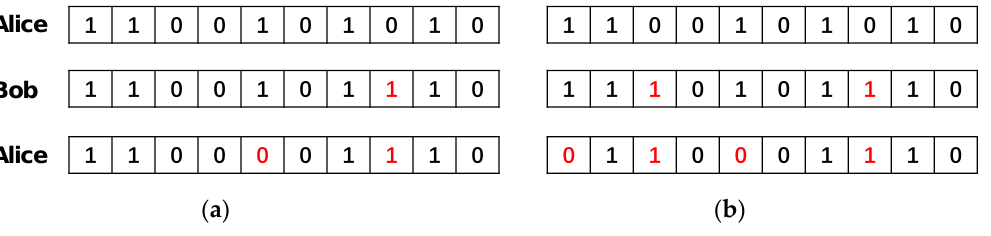
Figure 4. ( a ) Basis-consistent situation. ( b ) Basis inconsistency.